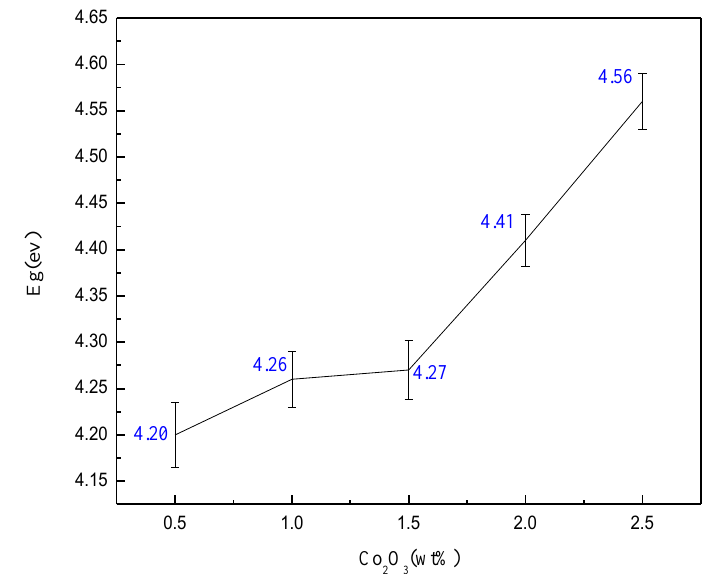
Figure 4. The relationship between the band gap and the Co content of Mg-based lanthanum hexaaluminate samples prepared at 1450 °C.